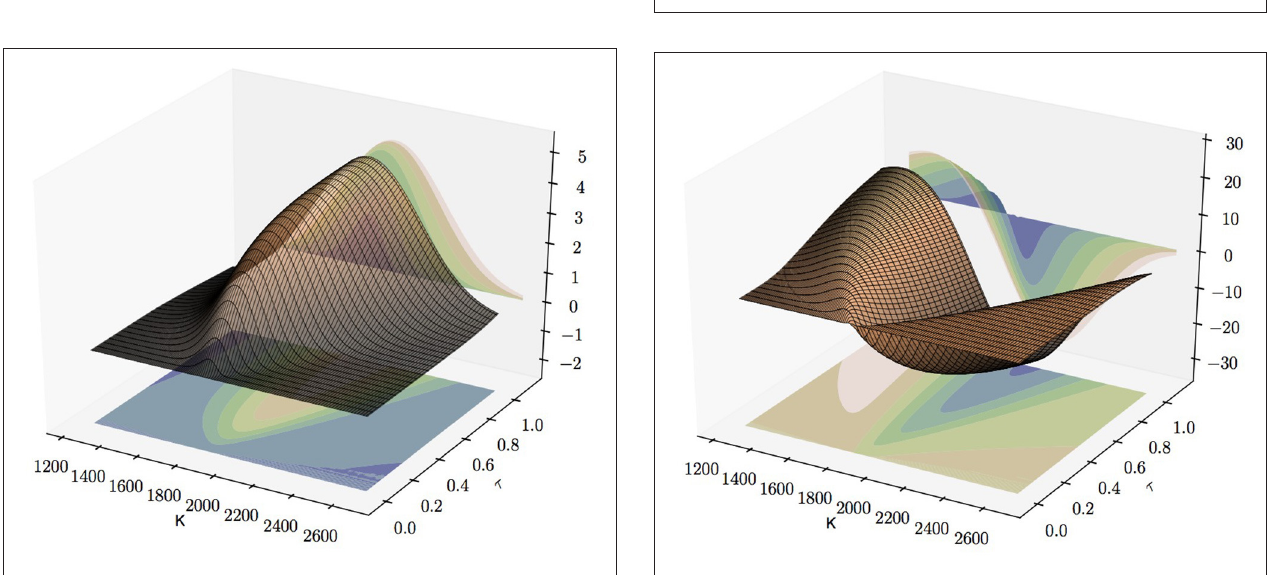
FIGURE 2 | The derivative of Heston’s call price w.r.t. the relaxation parameter κ .